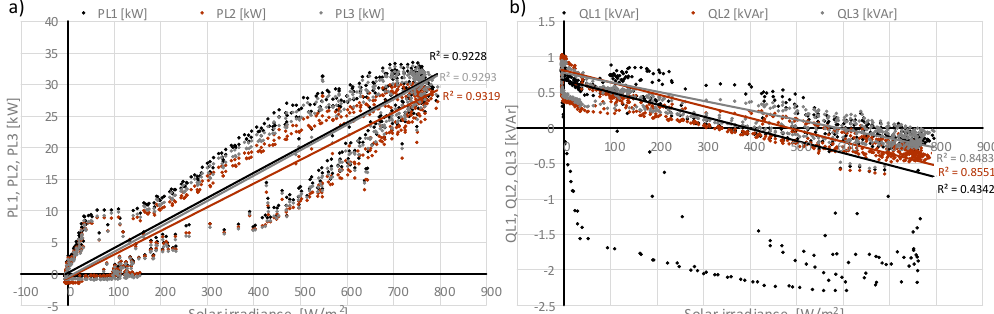
Figure 14. Correlation analysis between solar irradiation and active power ( a ) and reactive power ( b ) in PCC of PV power plant PV-C during the investigated week.